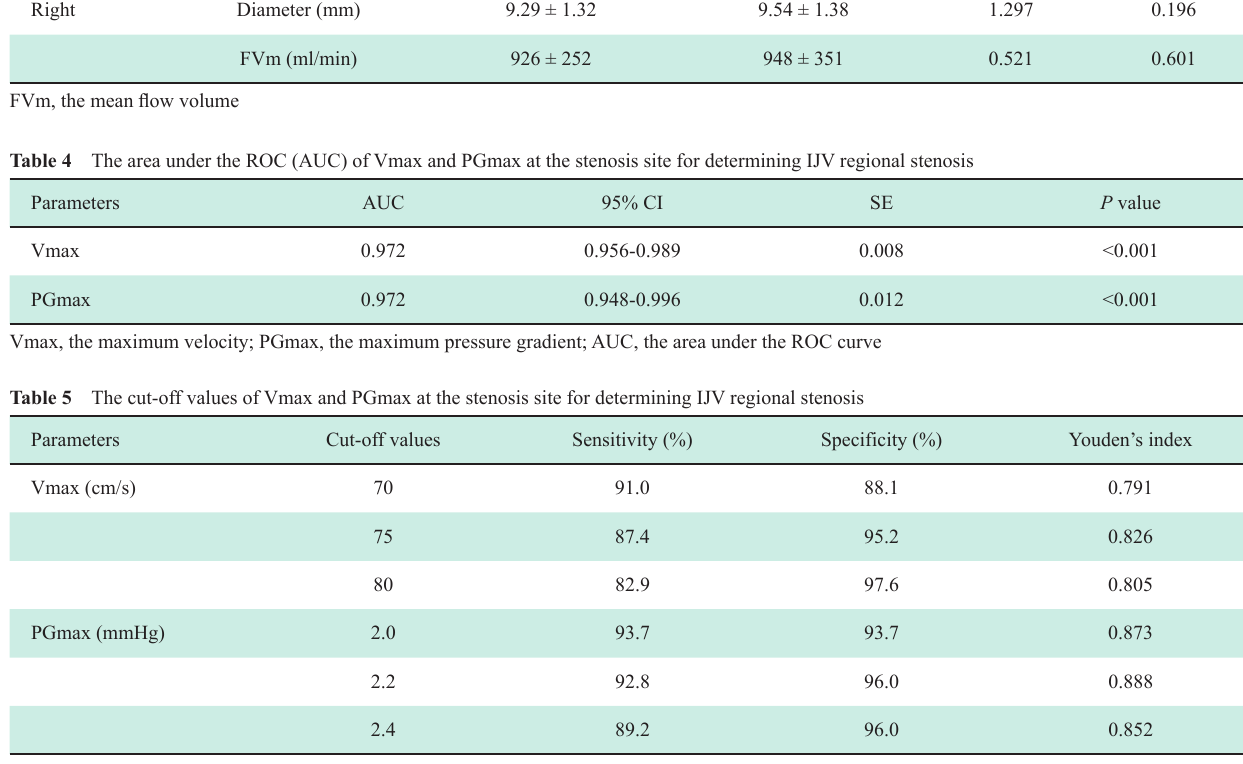
Table 3 Comparison of the diameter and FVm at the J1 segment between the study group and control group Side Parameters Control group Study group t value P value Left Diameter (mm)